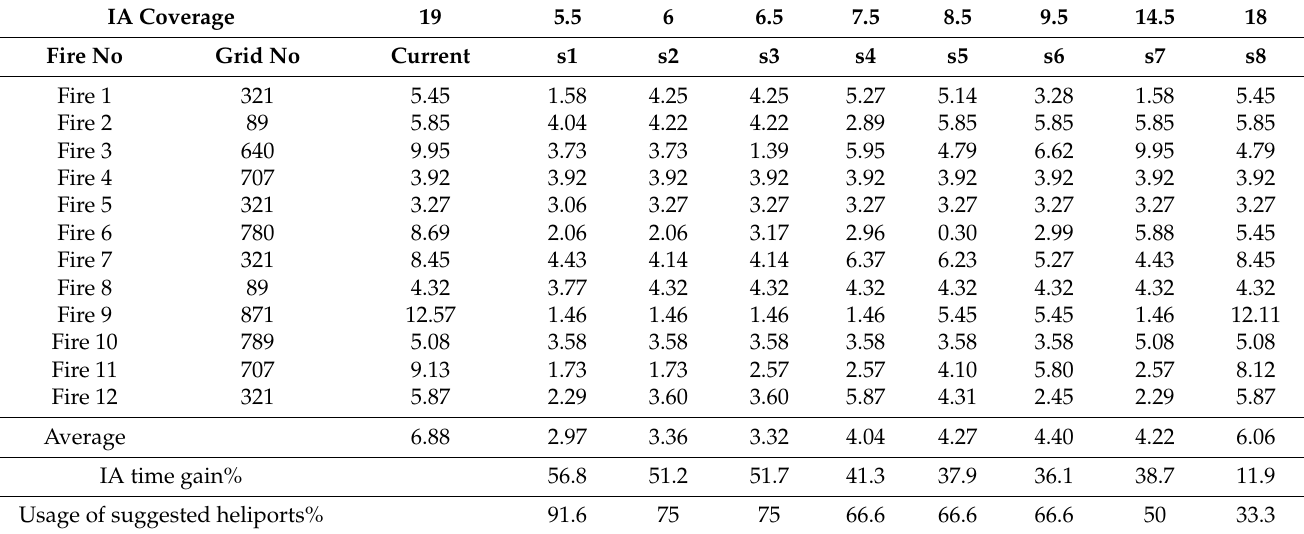
Table 5. IA times in all solutions for the historical